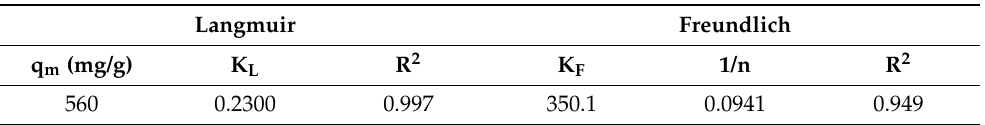
Table 2. The parameters of Freundlish and Langmuir isotherm models for the removal of Cr(VI) on the surface of ppy/NC nanocomposite.